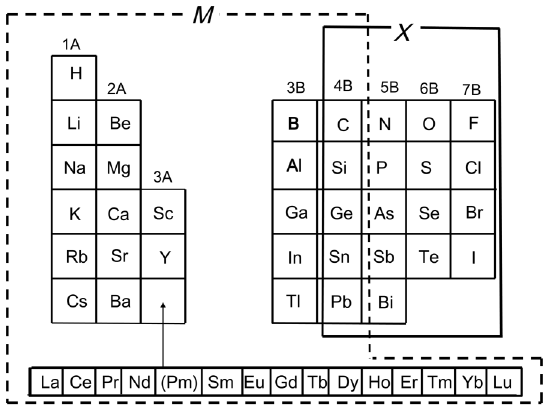
FIG. 1. Elements considered in the screening for 2D